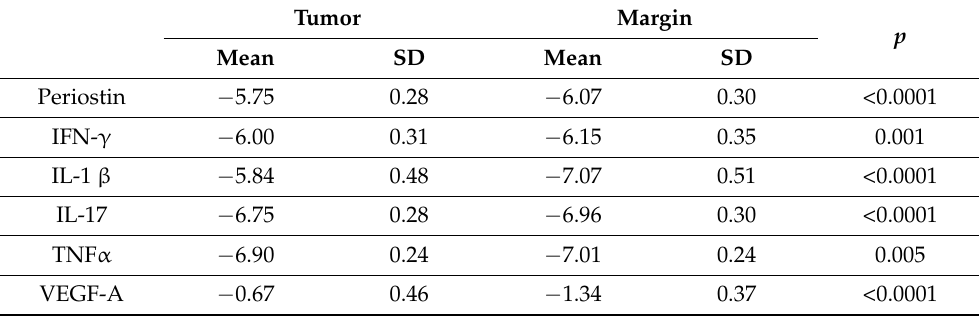
Table 2. Levels of periostin, VEGF-A, IFN- γ , IL-1 β , IL-17 and TNF α molecules in tumor and